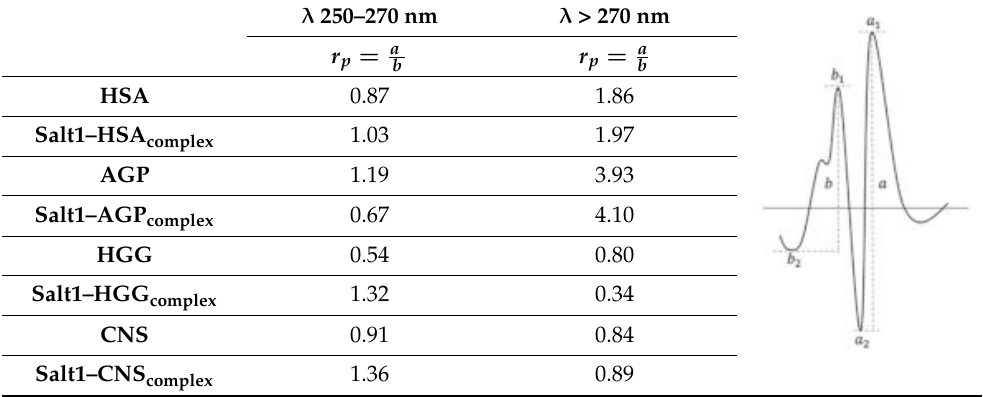
Table 3. r p values calculated from the second derivative differential absorption spectra of pheny- lalanyl and tyrosyl/tryptophanyl residues of HSA, AGP, HGG and CNS in the presence of Salt1 at Salt1:protein 4:1 molar